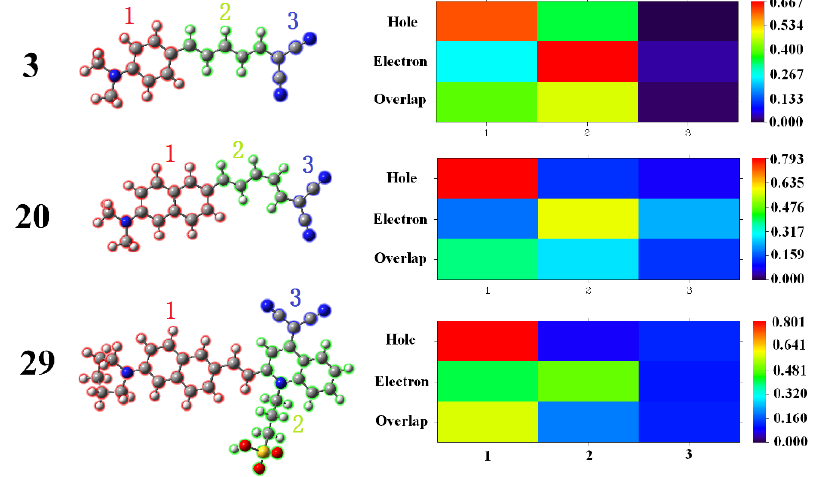
Figure 9. The partitions of probes 3, 20, and 29 and the electron–hole distribution heat maps for the molecular in the first excited state.